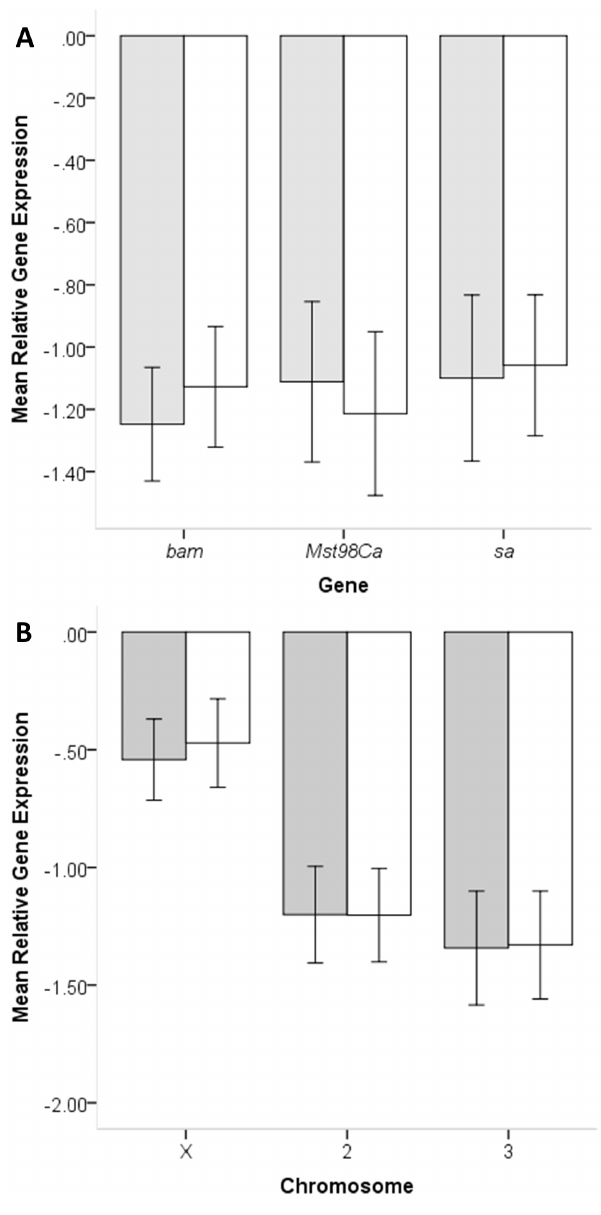
Figure 2. Differences in mean relative gene expression among genes (A) and chromosomes (B). Relative gene expression is shown as log 2 deviations from D. simulans and using RpL32 (grey bars) and RpS18 (white bars) as housekeeping reference genes (see Materials and Methods). A) Mean gene expression averaged across all introgression strains and B) mean expression per site of chromosome